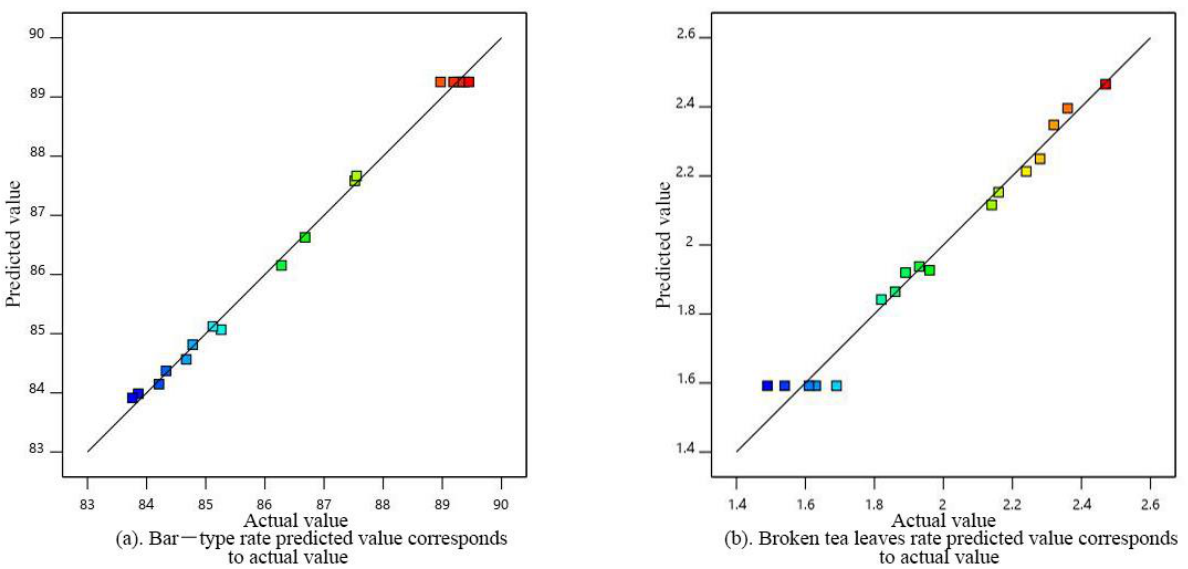
Figure 13. Analysis of calculated and predicted values of bar-type rate and broken tea leaf rate .